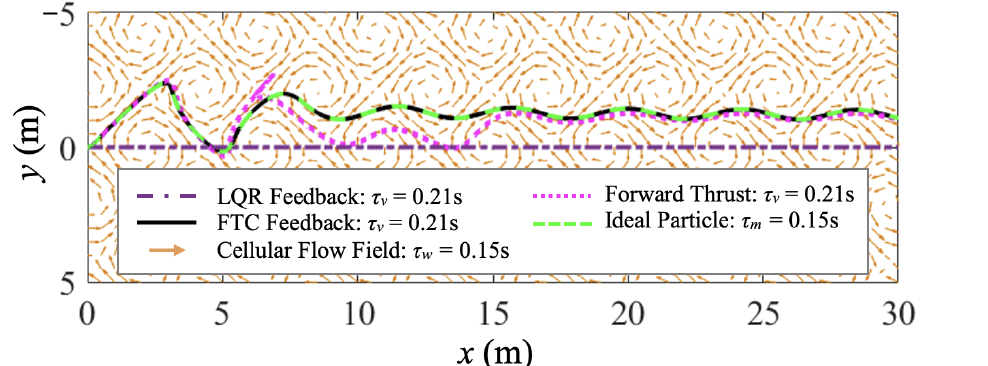
Figure 3. Case study 1: the trajectory comparison of the ideal fast-tracking particle with τ m = 0.15 s, and purely thrust-driven, FTC-controlled, and LQR-controlled vehicles with τ v = 0.21 s traversing a cellular flow with τ w = 0.15 s demonstrates that the FTC-controlled vehicle can perfectly follow the fast-tracking particle with zero tracking